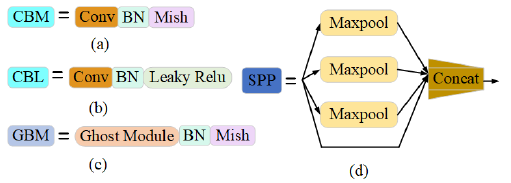
Figure 6. ( a ) CBM module ( b ) CBL module ( c ) GBM module ( d ) SPP module.